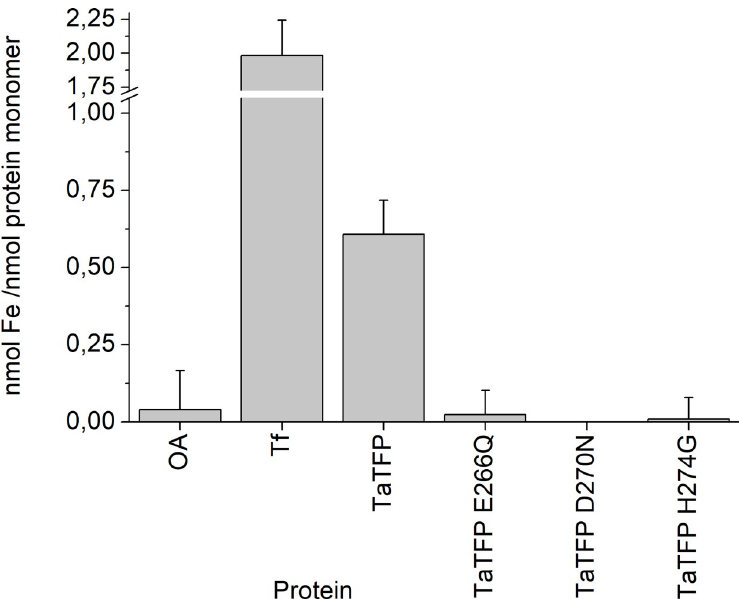
Fig 2. Ferene S quantification of iron in TaTFP wildtype and mutants. Proteins (in 37.5 mM sodium acetate buffer, pH 5, with 6.25% (w/v) sucrose) were denatured and precipitated. Fe 2+ in the supernatant was quantified colorimetrically using Ferene S reagent and calibration with (NH 4 ) 2 Fe(SO 4 ) 2 . OA, ovalbumin; Tf, holo-transferrin. Shown are means ± SD (N = 6 independent expression experiments).